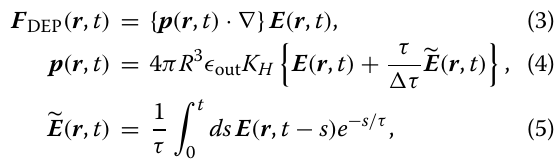
unable to return to the same position on the microelec- trode surface because of the solvent flow, which is not only observed in Additional file 1: Movie S6, but is also rep- resented by the U-turns with the cell migrating in the x direction in Fig. 2. Despite the interference with the sol- vent flow, it is possible to distinguish the moments when the cell starts to leave the microelectrode surface and does the U-turn in the periodic trajectory,